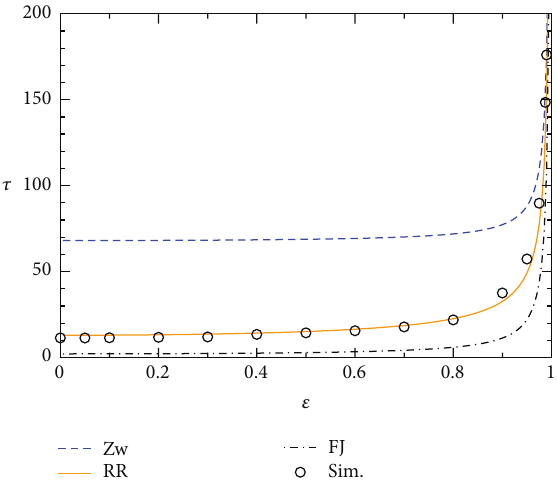
Figure 4: Comparison of 𝜏 from (24), black dash and dot line, (33), blue dashed line, and (40), orange continuous line, with data from computer simulations (circles), are plotted against the eccentricity 𝜀 of the elliptic tube (given 𝑅 = 1, 𝑎 = 0 . 05).